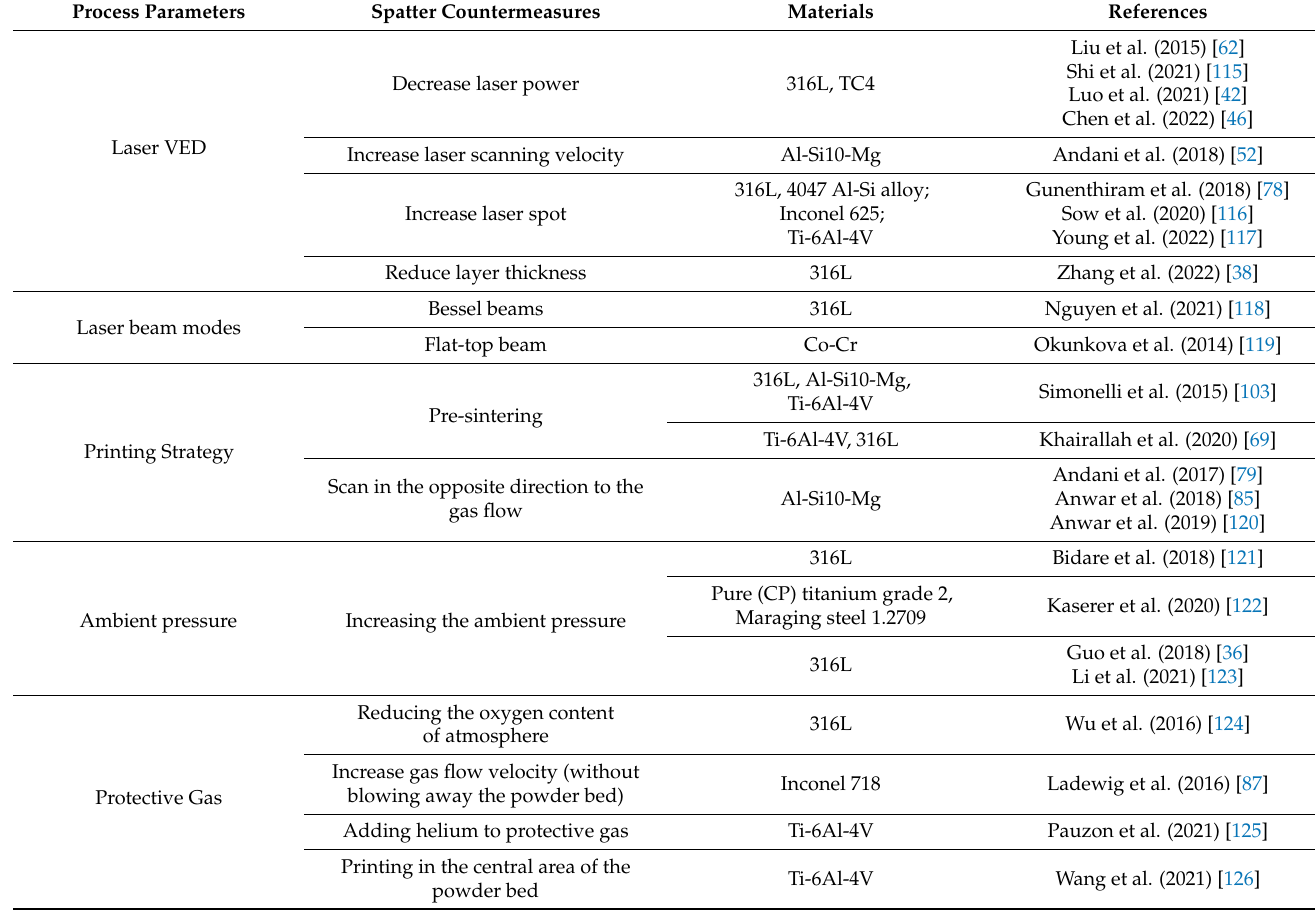
Table 9. Summary of studies on the regulation of process